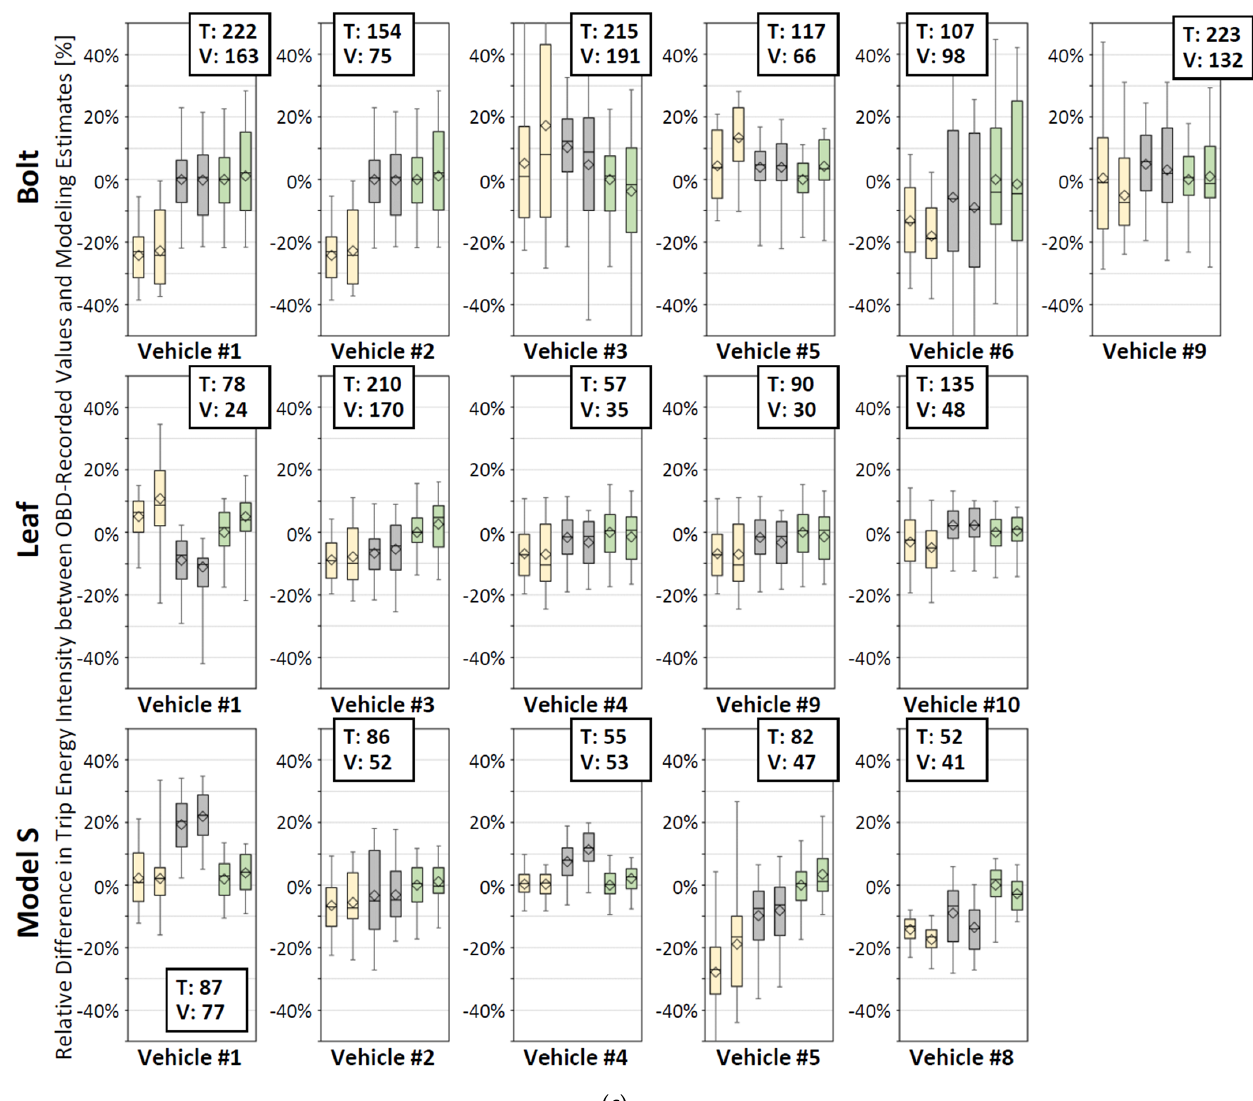
Figure 2. ( a ) Individual vehicle samples (Prius HEV, CR-V, Pacifica Hybrid) validity assessment of trip energy intensity. ( b ) Individual vehicle samples (C-Max Energi, Prius Prime, Volt) validity assessment of trip energy intensity. ( c ) Individual vehicle samples (Bolt, Leaf, Model S) validity assessment of trip energy intensity.